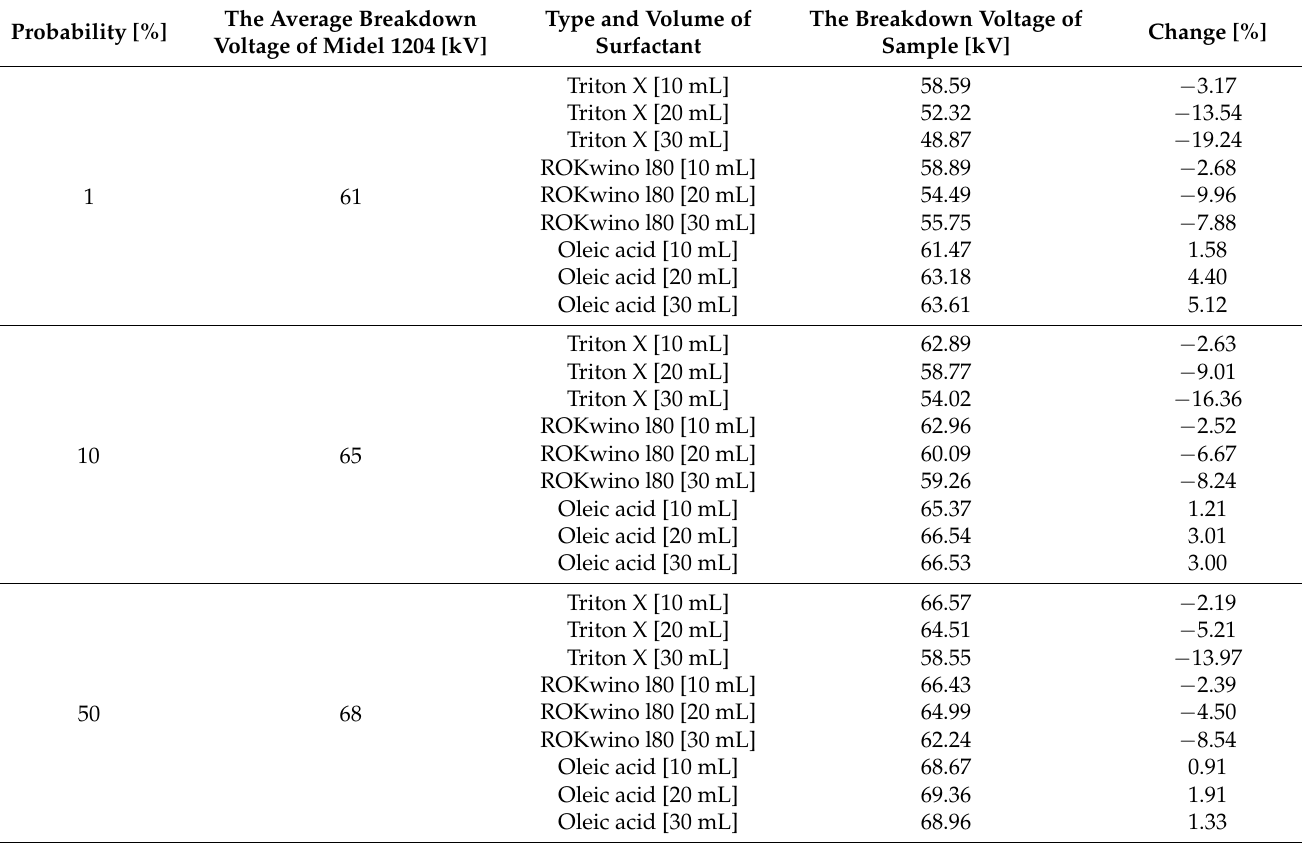
Table 7. Selected probabilities of Weibull distribution for all